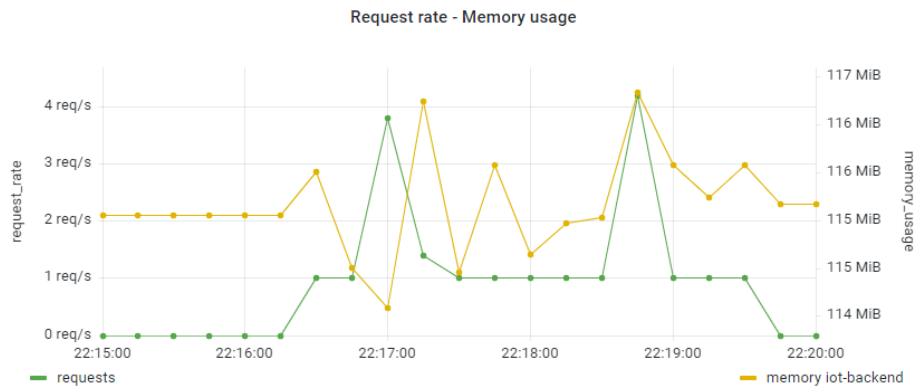
Figure 16. Memory usage for the IoT Backend component under the bursty